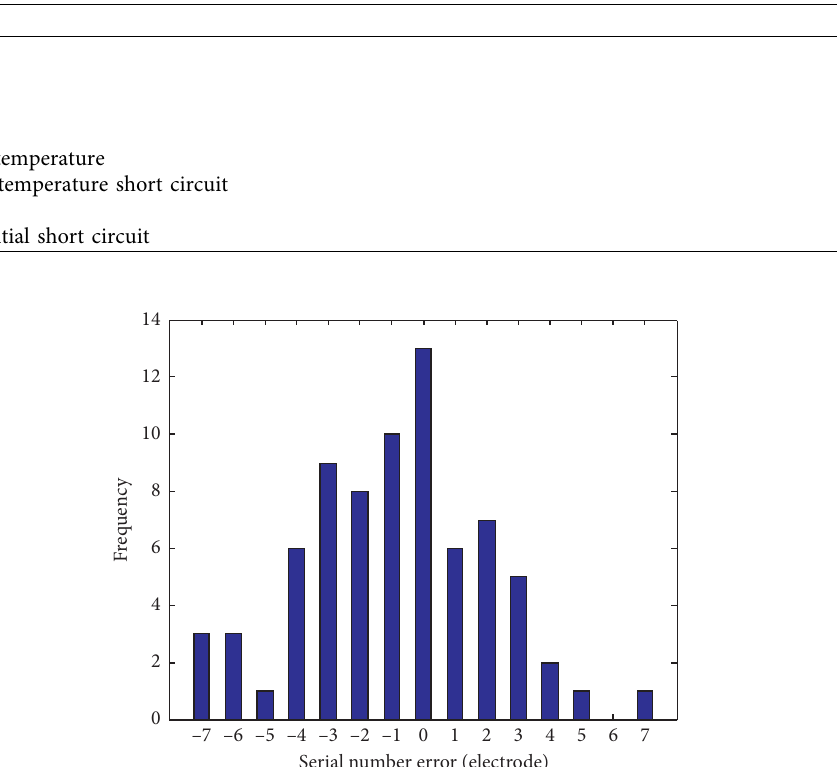
Figure 16: Histogram of serial number error of grand-truth short